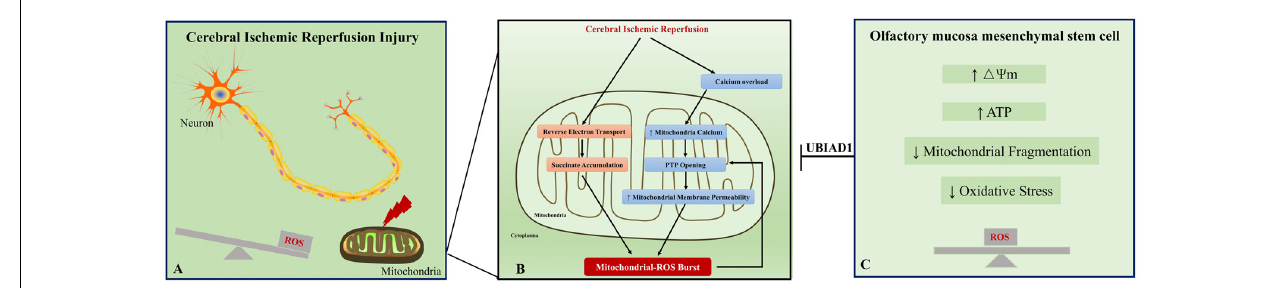
FIGURE 7 | A schematic representation of the proposed mechanism between oxidative stress and mitochondrial dysfunction in cerebral ischemic reperfusion injury. Excessive oxidative stress and mitochondrial dysfunction are fundamental contributors to neuronal injury in cerebral ischemic reperfusion injury (A) . Ischemic/reperfusion condition induces calcium overload, which results in calcium influx into mitochondria and mitochondrial permeability transition pore (PTP) opening. Meanwhile, accumulation of intermediate succinate results from reverse electron transport from mitochondrial complex II to complex I. These changes contribute to ROS burst in the neuron. The excessive ROS reversely leads to PTP opening and forms a vicious circle in cerebral ischemic reperfusion injury (B) . Our study provides evidence that the impaired oxidant/antioxidant balance and mitochondrial dysfunction could be rescued by OM-MSC treatment (C) . Collectively, OM-MSC implantation is a promising approach for the management of cerebral ischemic reperfusion